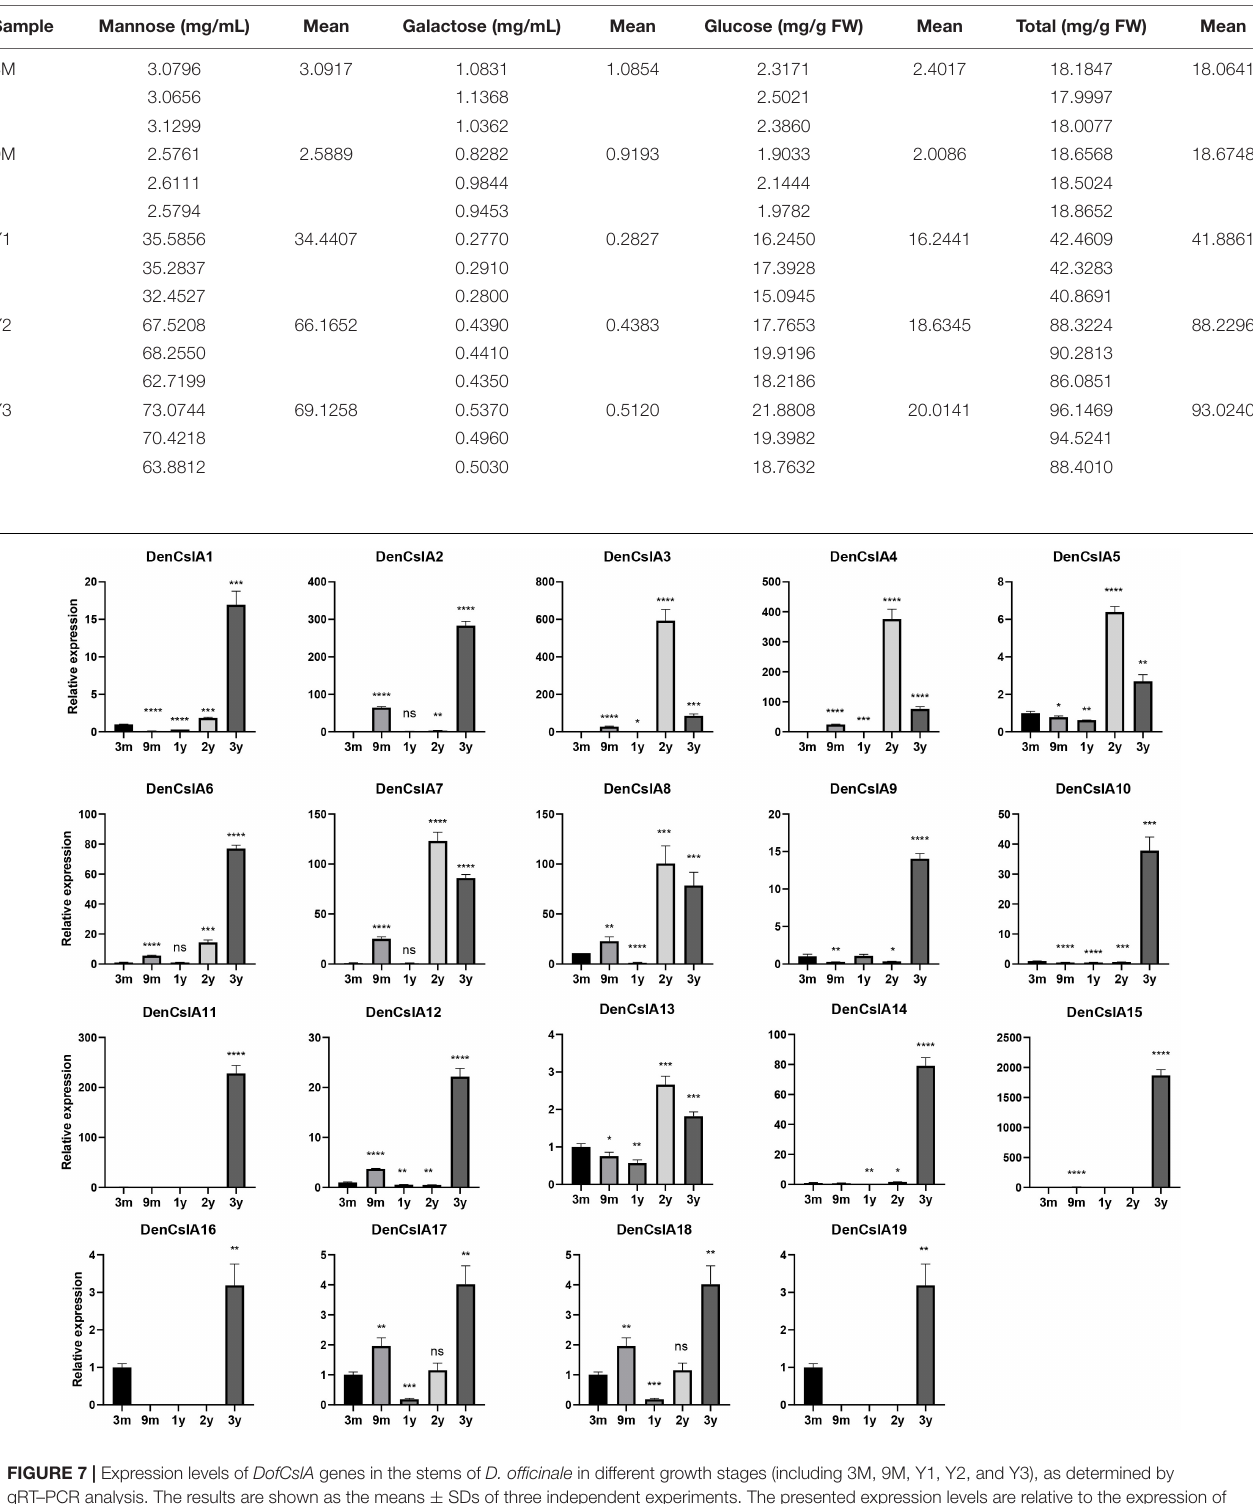
Frontiers in Plant Science |